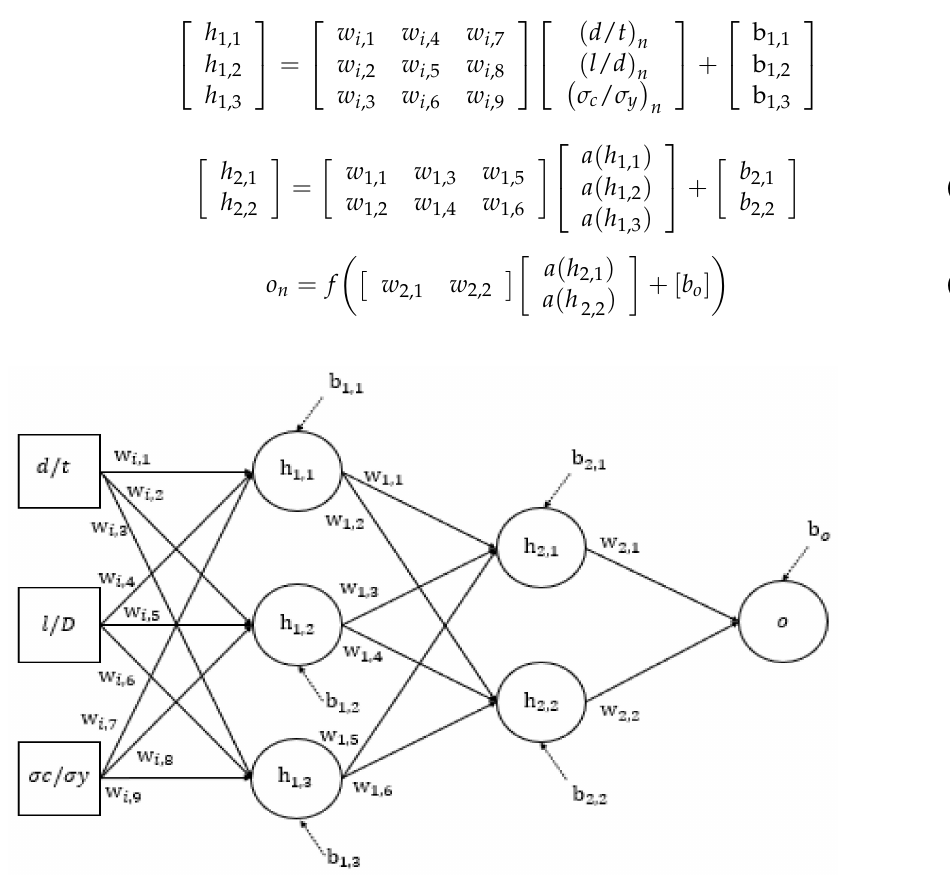
Figure 14. Architecture of the ANN model. The input values of the ANN are normalised by the ANN model so that the normalised input value, i n , falls within the range of − 1 to 1 before the values are transferred to the first hidden layer. Hence, the inputs need to be normalised using Equation (12) before being used. Likewise, the output values that were used to train the ANN model were normalised to range between the values of − 1 and 1. Hence, the final output, o , must be denormalized using Equation (13), to obtain the failure pressure of the corroded pipe.